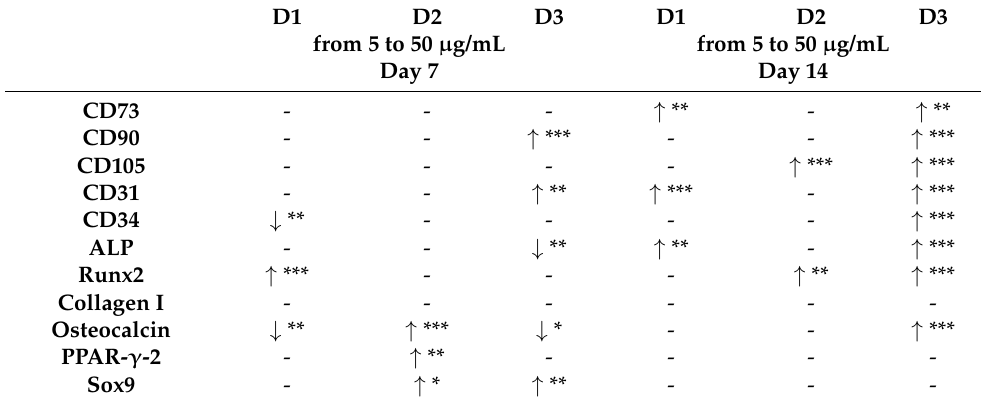
Table 2. Changes in gene expression of ASCs from three Donors (D1–D3) in the presence of 50 µ g/mL suspended in basal medium DMEM, after incubation of 7 days and 14 days, respectively. Detailed